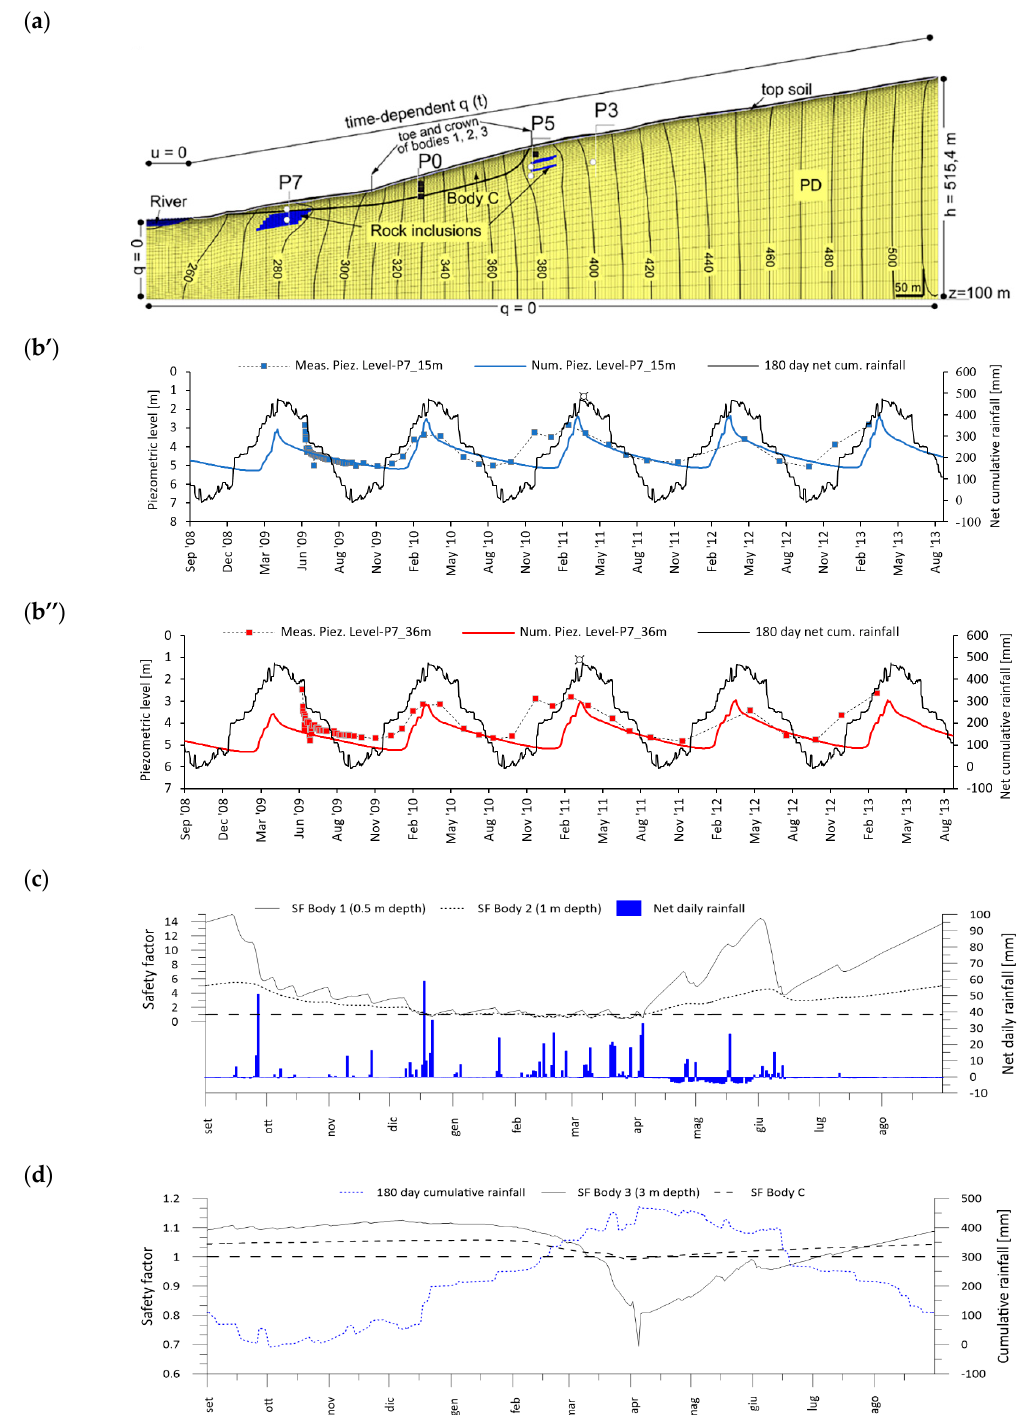
Figure 9. Hydraulic modelling and limit equilibrium analysis of the slope-vegetation-atmosphere interaction for the Pisciolo slope: ( a ) FE slope model, boundary conditions and equipotential lines at the end of the steady state hydraulic modelling; results of the hydraulic modelling: hydraulic heads for the piezometric cell, along the vertical P7 (Figure 6), at 15 m ( b’ ) and 36 m ( b’’ ) compared with monitoring data (blue and red dots) together with 180-day net cumulative rainfall; results of the limit equilibrium analysis: ( c ) safety factor (SF) variation during the year for shallow landslide bodies, together with the daily net rainfall; ( d ) safety factor (SF) variation during the year for deep landslide bodies together with the 180-day cumulative rainfall; (modified after [40,61]).